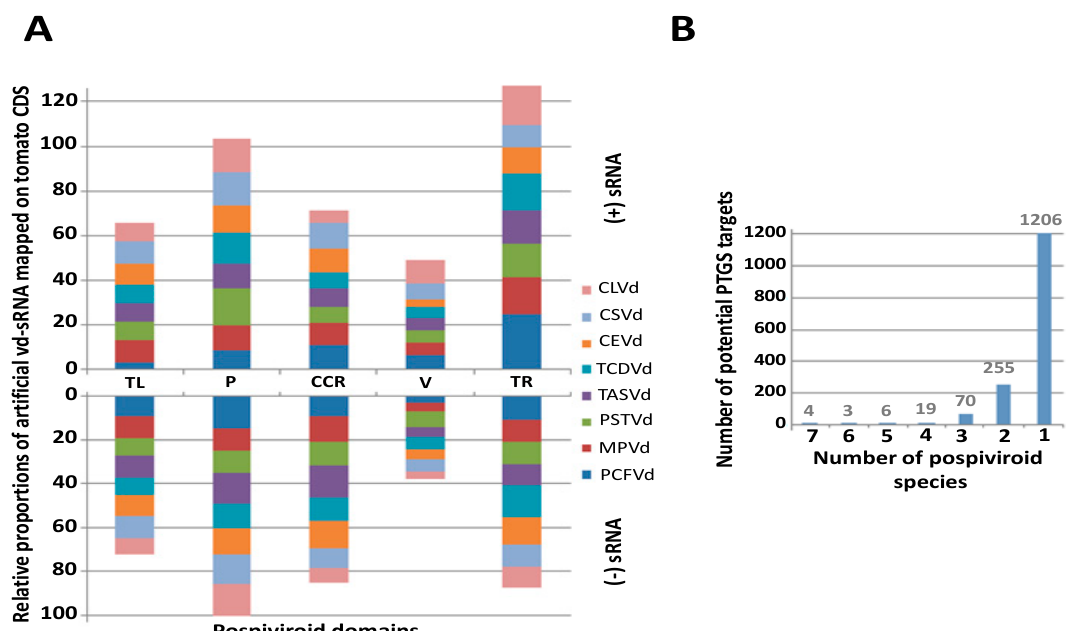
Figure 1. ( A ) Distribution among the five pospiviroid domains of the percentage of artificial 21 nt vd-sRNA mapping to tomatoes CDS for each of the eight pospiviroid species able to infect tomatoes (three mismatches/indels allowed). The upper part of the bar graph shows targets of the positive strand of pospiviroids; the lower part shows targets of the negative strand. Statistical differences between domains are represented as binomial regression groups ( P < 1e − 5 above the upper bar of each domain. The five pospiviroid domains are mentioned according to the following abbreviations: TL—Terminal left; P—Pathogenicity, CCR—Conserved central region; V—Variable; TR—Terminal right. ( B ) The number of potential PTGS targets shared among pospiviroid species according to the mapping of in silico -generated vd-sRNAs from a set of 891 complete genome sequences of pospiviroids. Here, only the most thermodynamically-stable sites of Table S2a ( ∆ G ≤ − 25 kcal/mol) were reported in this graph.